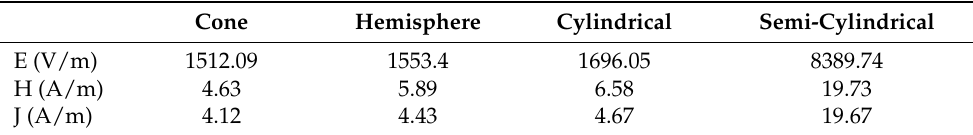
Table 2. Electric field peak at different defects. Cone Hemisphere Cylindrical